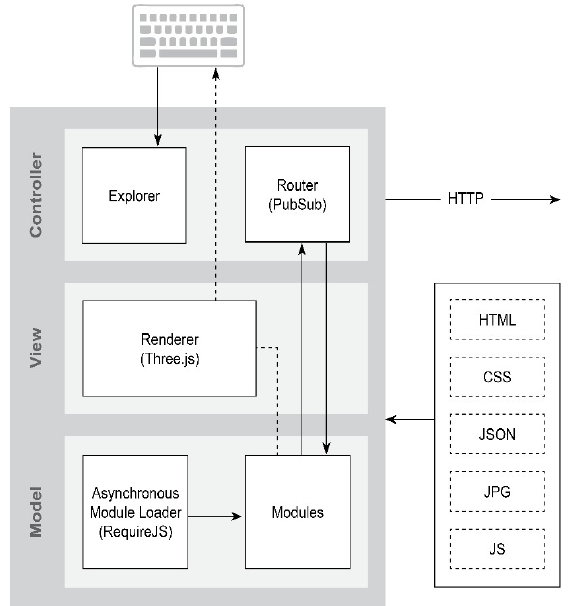
Figure 3. Event flow proposed by CW4P. Source: adapted from [10].